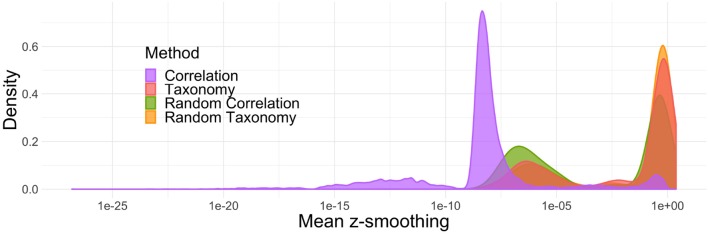
Average absolute difference between z-scores before and after smoothing. In most simulations, smoothing only marginally changes the results.